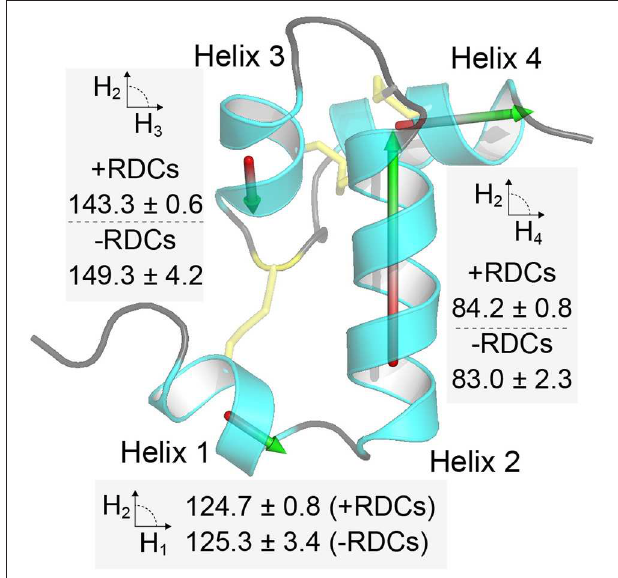
FIGURE 4 | Inter-helix orientations are better defined when including RDC restraints. In the figure each of the four helices in Ta1a is represented by a vector, and in each case the angle between each vector and the central helix 2 vector is calculated. The procedure is repeated for each structure in the ensemble and the average and standard deviation provided in the figure near the relevant helix. The procedure applied to the ensemble of structures when RDCs are included or omitted in the structure calculation step ( + and – RDCs, respectively). Helix 3 shows the largest deviation and spread of orientations when RDCs are not